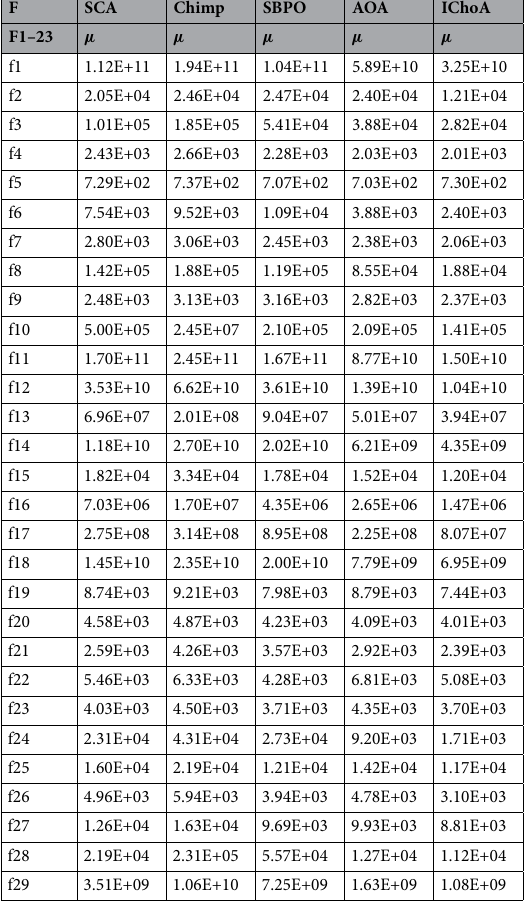
best and worst symbols have been assigned by the average values of Table 3. Normally the least average score shows the accuracy of the algorithm in finding the best optima in the search area. Results of Table 5, proof that the IChoA gives the least average value on maximum test suites as comparison than others. Hence it can be con- cluded that the IChOA method is able to provide the best or accurate solution for the complex suites than others. Stability. In Fig. 2 the standard score of each method has been plotted. This graph has been plotted against the results of Table 4. If the standard score of algorithms lies near to zero this shows the stability of the algorithm for the optimal solutions of the given suites. In Table 4 and Fig. 2, it can be easily see that the IChoA is providing the least standard score at maximum test suites against the other methods. The least standard also shows the fast convergence speed of the algorithm for traps the optima in the search area. Hence the results of table and figure, gives the proof of the stability and fast convergence speed of the proposed method against others that the IChOA is able to trap the optima score fastly outperforms than others. Convergence graphs analysis and discussion. The convergence performance graphs of algorithms are drawn against the number of the iterations and best solution so far etc and presented in Figs. 3, 4, 5, 6. Kindly keep in mind that the best optima that are obtained against every iteration which illustrated through the best solution so far. In Figs. 3, 4, 5, and 6, the x-axis denotes the number of iterations and y-axis illustrates the best solution found against each iteration during the search process. As per V.D. Berg et al. 40 ,this behaviour can guarantee that the evolutionary methods eventually touch to a target and find the local or global in a search domain. So, IChoA improves the fitness score for all chimps in a search area and assurance traps accurate targets for complex suites as iteration rises. Here can be said that this happens by this modification of the ChoA method. As each chimp travels from highest optima to lowest optima score, therefore with the hypothesis of growing in ChoA, the overall champs and their fitness values are amended against each iteration. With this strategy we save the best score and apply these scores for finding the next best location for the entire swarm in the search area. Experiments and convergence graphs shows that the IChoA method is capable of giving the higher grantee finds the optima against the least number of iterations in a complex space as comparison to